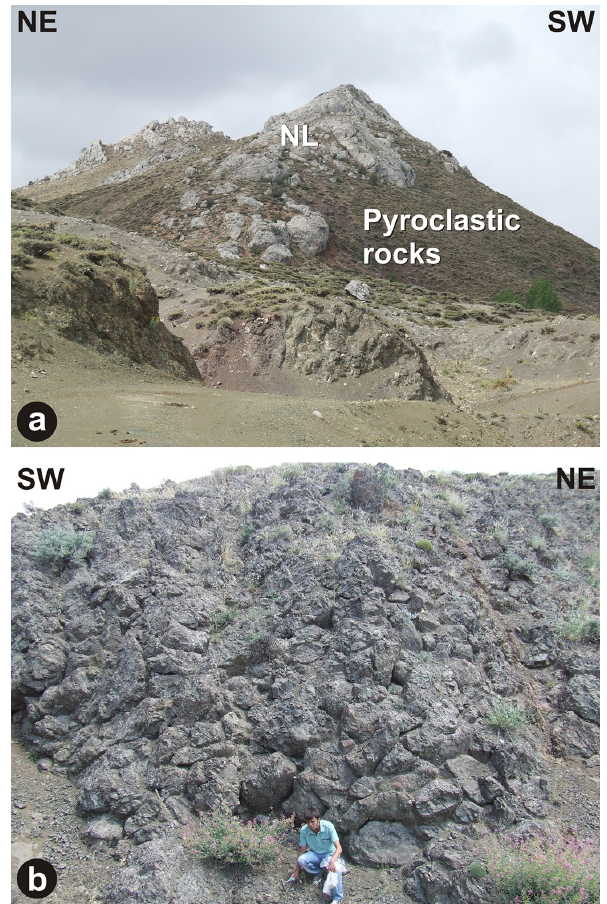
Fig. 8. (a) Neritic limestone covering the seamount volcanic- volcaniclastic rocks in the Ankara Mélange. (b) Seamount pillow lavas in the Ankara Mélange. NL = neritic